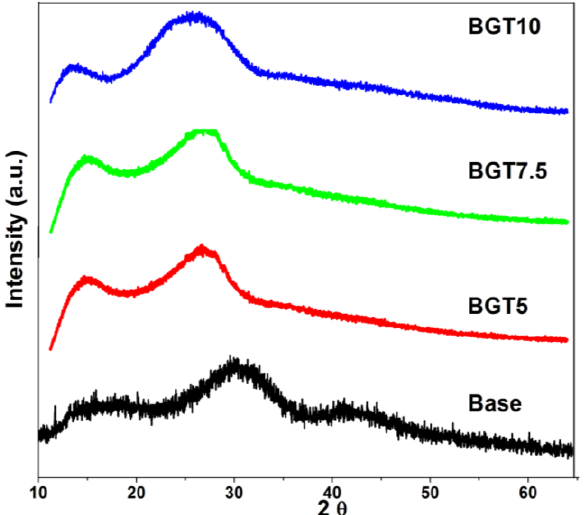
Figure 2. X-ray diffraction curves of the prepared glasses doped with TiO 2 .